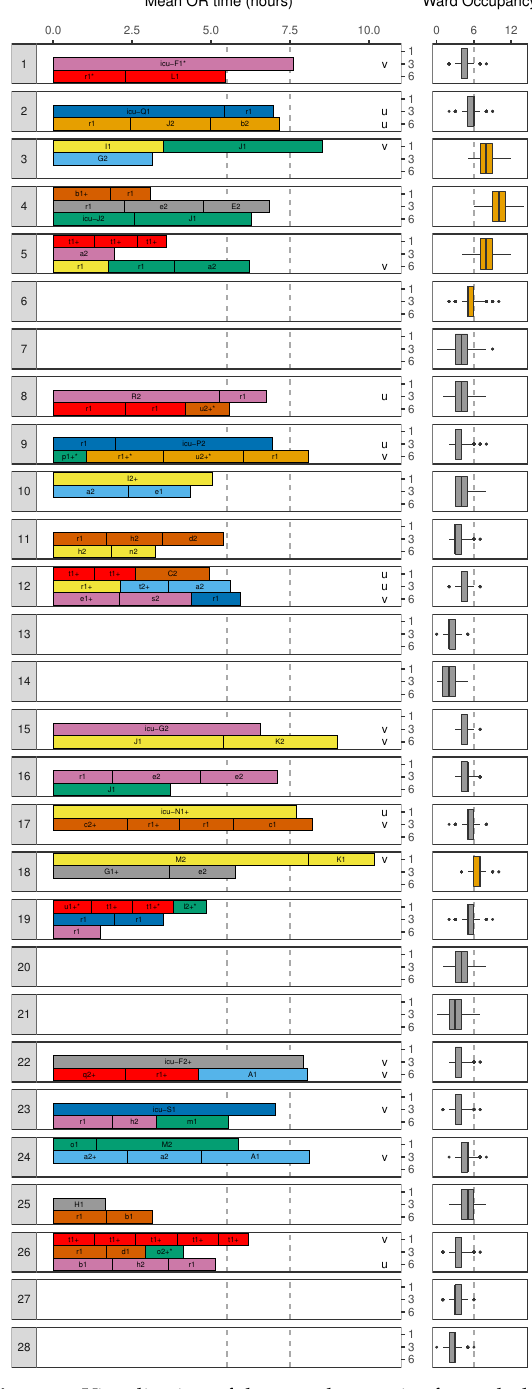
Figure 3. Visualisation of the actual surgeries for each day and OR (1, 3 and 6) and the corresponding ward occupancy (for the ward occupancy, the color is yellow if there is risk of overflow and grey if not. The dashed line represents the maximum number of staffed ward beds ( M A )). Colors reflect the operators, and the text is the code of the surgical procedure (if the surgical procedure code is in upper case, ward admission is required. The symbol + denotes if a patient arrived during the execution of the schedule, ∗ denotes one-week priority and ICU denotes if ICU is required. The dashed lines represent the distinct opening hours of the ORs ( C d , r )). The tags u and v denote if the threshold for the risk of regular or extended overtime is surpassed,